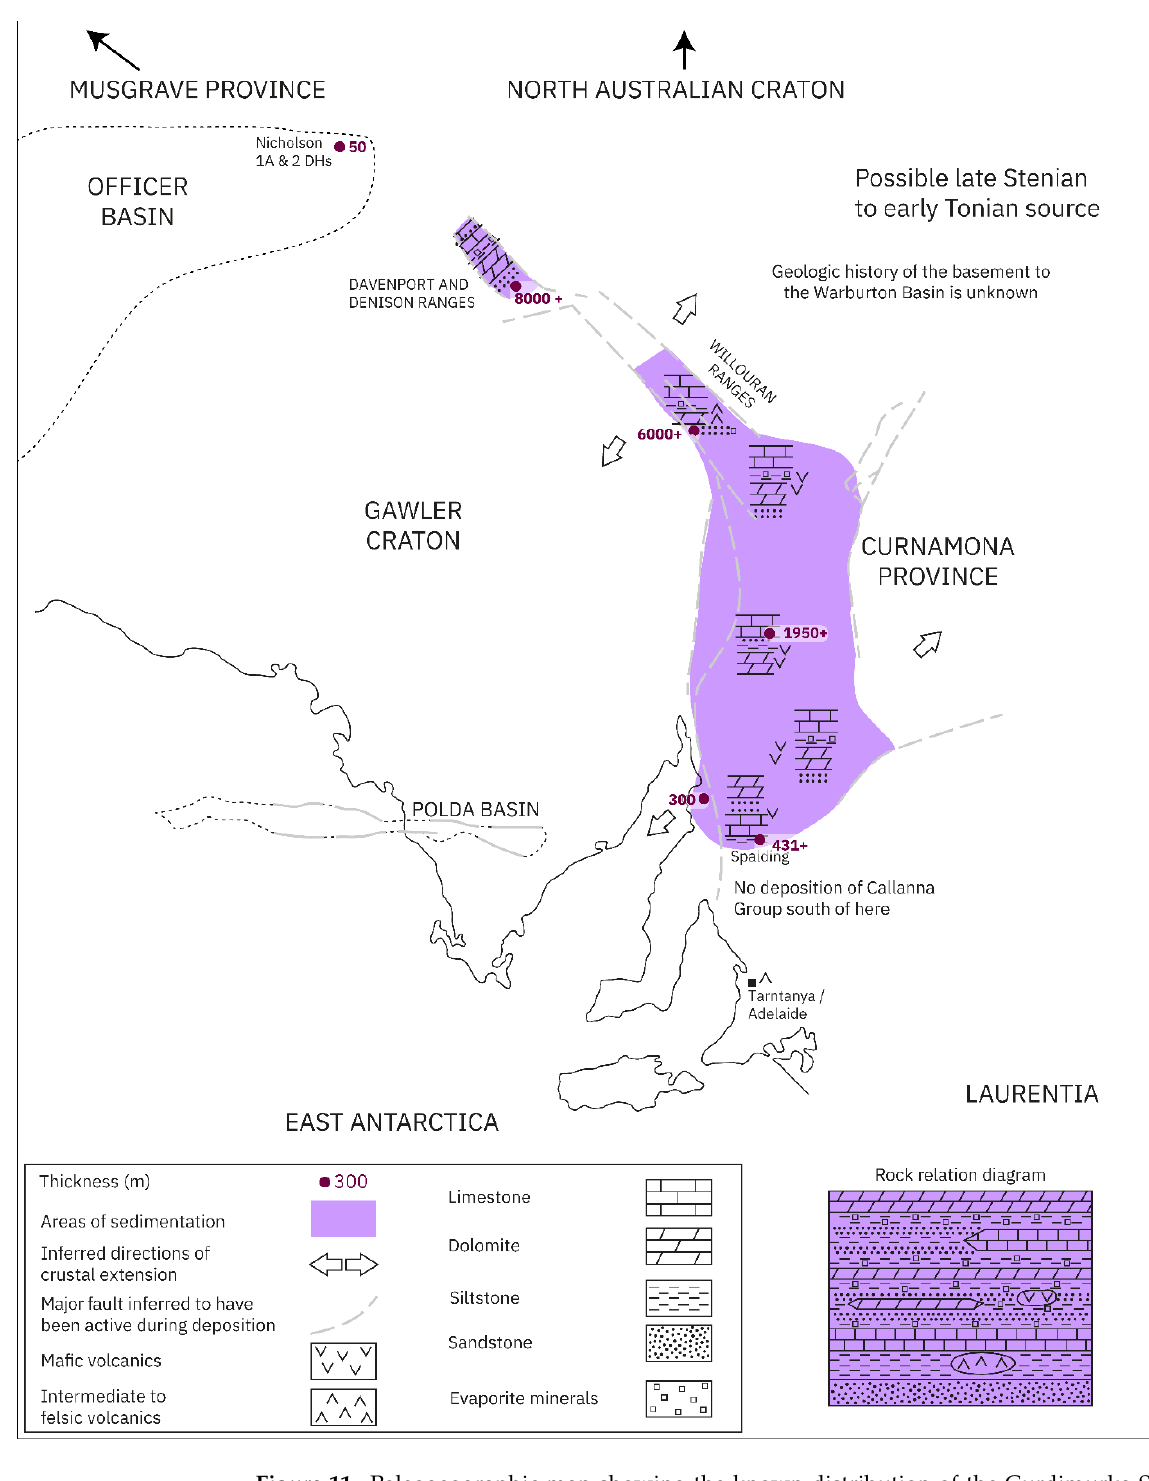
Figure 11. Paleogeographic map showing the known distribution of the Curdimurka Subgroup (c. 830–800 Ma) sedimentary deposition. Relative positions of relevant continental blocks in Rodinia are also indicated. Geography of the Adelaide Superbasin is shown in its modern-day configuration, with the modern coastline shown for reference. Adapted from Preiss [41].